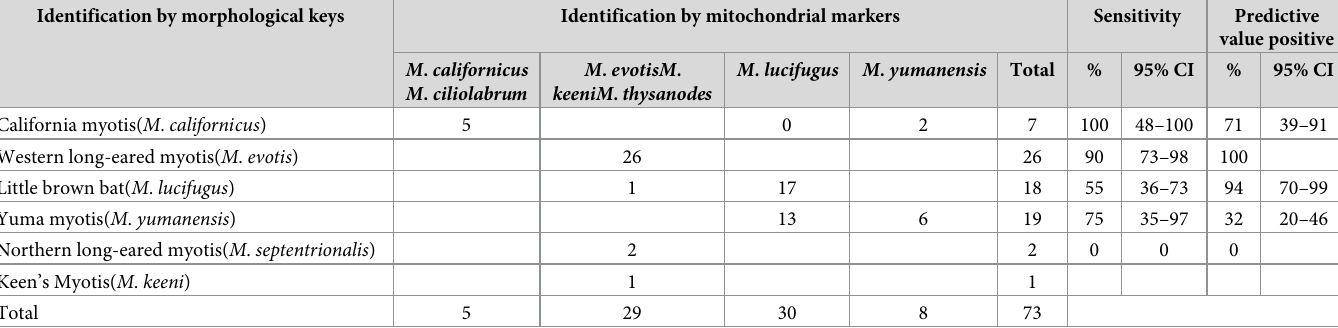
Table 1. Number of Myotis spp. bats identified with morphological keys (rows) and mitochondrial markers (columns). Sensitivity and predictive value positive of morphological identification are calculated with mitochondrial markers as the reference. Identification by morphological